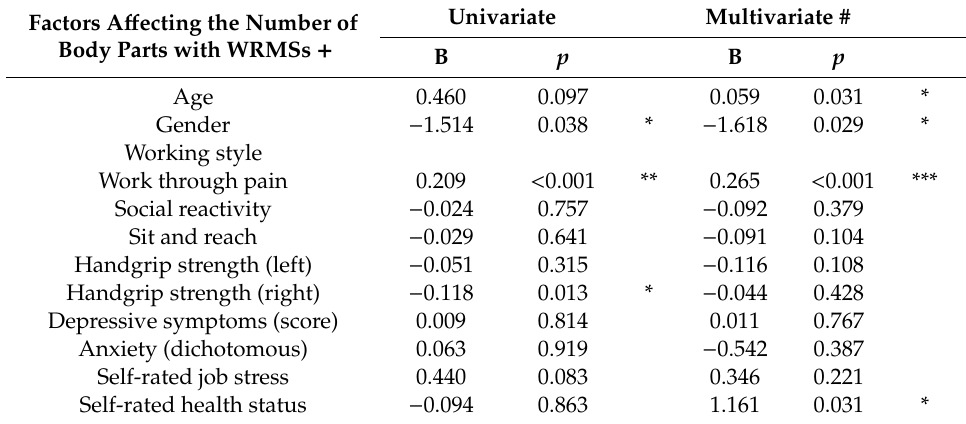
Table 5. Univariate and multivariate regression model studying factors a ff ecting the change in the number of body parts with WRMSs over time (T1 −